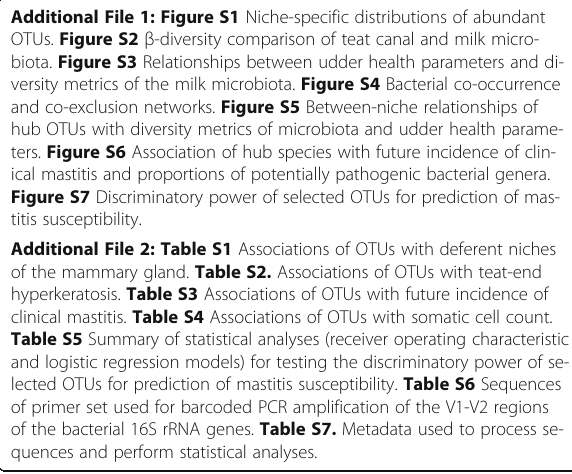
biota. Figure S3 Relationships between udder health parameters and di- versity metrics of the milk microbiota. Figure S4 Bacterial co-occurrence and co-exclusion networks. Figure S5 Between-niche relationships of hub OTUs with diversity metrics of microbiota and udder health parame- ters. Figure S6 Association of hub species with future incidence of clin- ical mastitis and proportions of potentially pathogenic bacterial genera. Figure S7 Discriminatory power of selected OTUs for prediction of mas- titis susceptibility. Additional File 2: Table S1 Associations of OTUs with deferent niches of the mammary gland. Table S2. Associations of OTUs with teat-end hyperkeratosis. Table S3 Associations of OTUs with future incidence of clinical mastitis. Table S4 Associations of OTUs with somatic cell count. Table S5 Summary of statistical analyses (receiver operating characteristic and logistic regression models) for testing the discriminatory power of se- lected OTUs for prediction of mastitis susceptibility. Table S6 Sequences of primer set used for barcoded PCR amplification of the V1-V2 regions of the bacterial 16S rRNA genes. Table S7. Metadata used to process se- quences and perform statistical analyses. Abbreviations ANOVA: Analysis of variance; AUC: Area under the curve; CoNet: Correlation network analysis; MG: Mammary gland; IMI: Intramammary infection; NAS: Non- aureus staphylococci; CM: Clinical mastitis; SCC: Somatic cell count; TC: Teat canal; TE: Tris-EDTA; EDTA: Ethylenediamine tetraacetic acid; rRNA: Ribosomal RNA; PCR: Polymerase chain reaction; FLASH: Fast length adjustment of short reads; OTU: Operational taxonomic unit; QIIME: Quantitative insights into microbial ecology; PyNAST: Python implementation of the nearest alignment space termination; CSS: Cumulative sum scaling; PCoA: Principal coordinate analysis; PERMANOVA: Permutational multivariate analysis of variance; MaAsLin: Multivariate analysis with linear modeling; FDR: False discovery rate; ROC: Receiver operating characteristics curve; SD: Standard